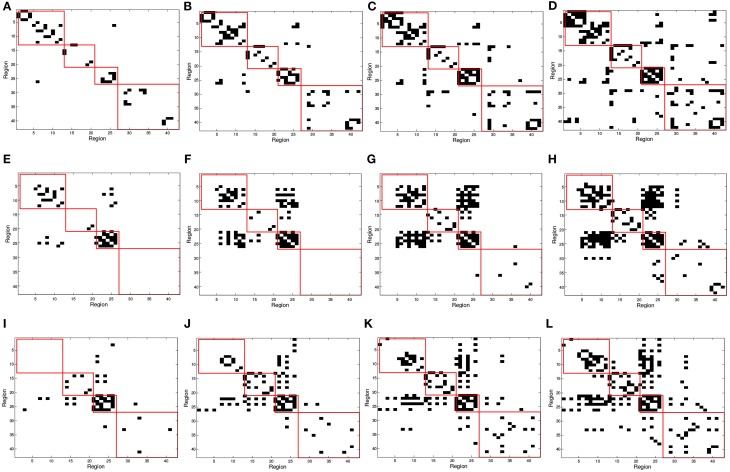
SICE matrix computed for (A,E,I) 25, (B,F,J) 50, (C,G,K) 75, and (D,H,L) 100 arcs using functional PET data. First row correspond to CN, second row corresponds to MCI, and third row to AD subjects. Red squares in Θ^ (from top to bottom, left to right) indicate regions contained in frontal, parietal, occipital, and temporal lobes.